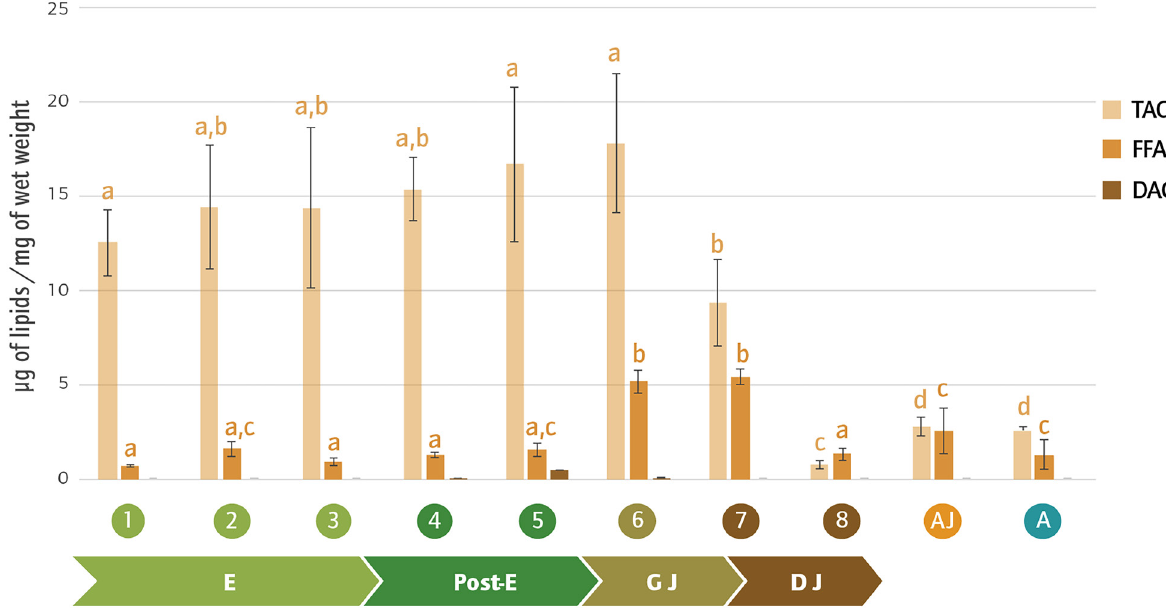
Figure 9. Concentration of energetic lipids during P. pythagoricus development until adult’s stage: triacylglycerides (TAG), free fatty acids (FFA), and diacylglycerides (DAG). Values are the means ± SDs. Different letters above the bars indicate significant differences among the different stages at p < 0.05, as determined by Tukey’s post hoc test. 1 to 8: stages of P. pythagoricus development; AJ: advanced juvenile stage; A: adult stage; E: embryonic period; Post-E: post-embryonic period; GJ: juveniles in gregarious stage; DJ: juveniles in dispersal